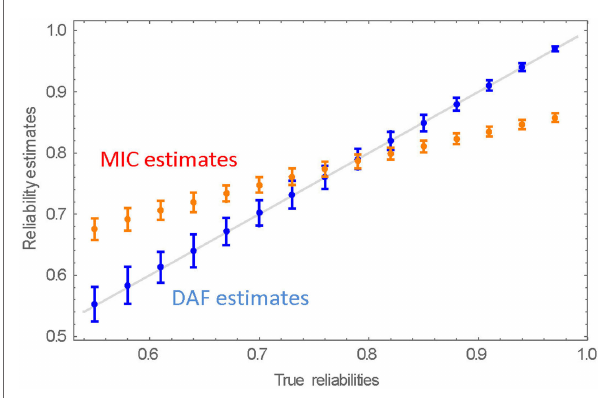
TaBle 5 | Dis-attenuated inter-rater correlations.